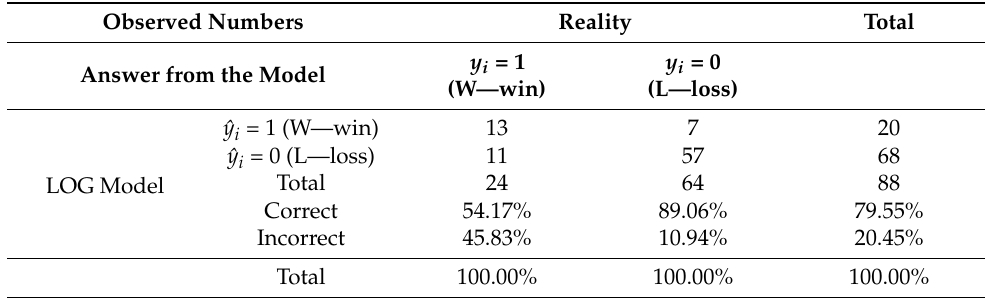
Table 9. Summary of classification for the LOG